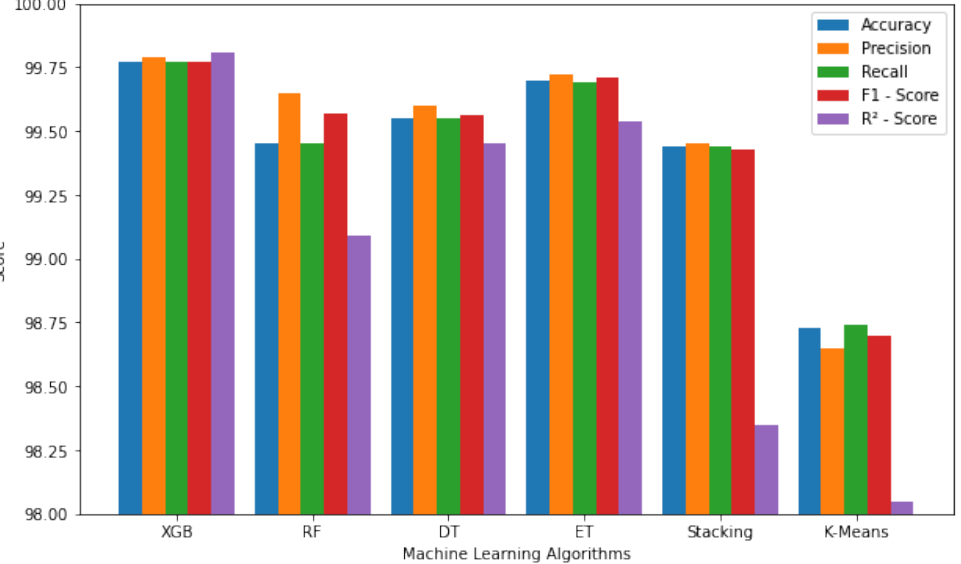
Figure 4. Effectiveness of the Intrusion detection system using the selected machine learn- ing